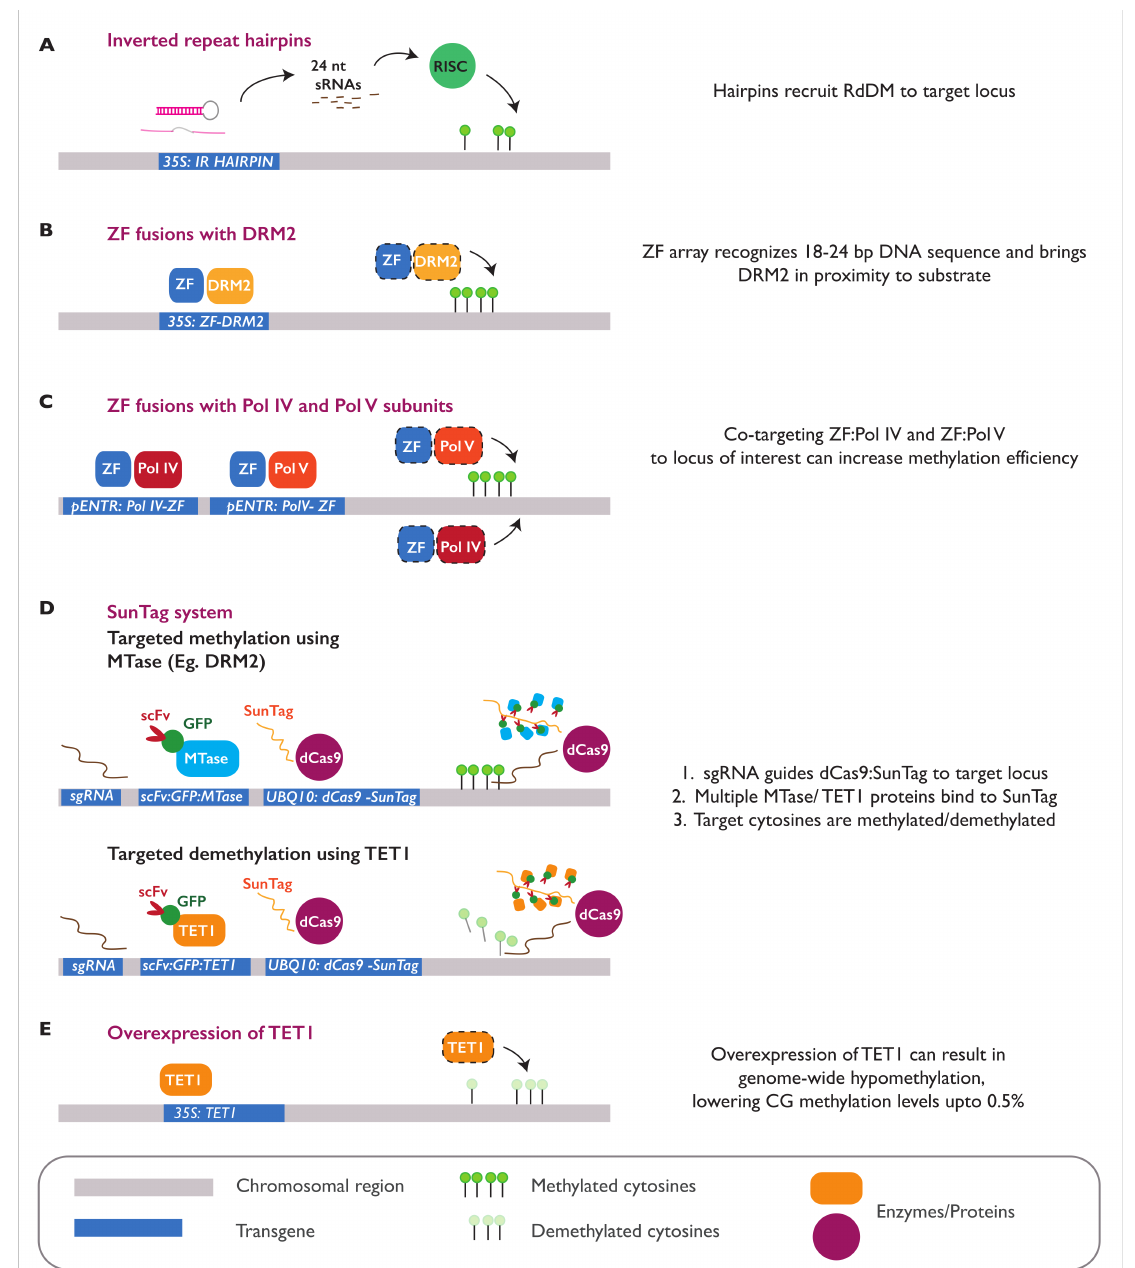
Figure 4. Different methods for targeted epigenetic engineering. DNA methylation can be introduced into specific regions in the genome using IR-hairpin constructs that can recruit a sRNA-induced silencing complex (RISC) into the target sequence ( A ), ZF constructs fused with methyltransferase genes such as DRM2 that can directly methylate cytosines at a target sequence through RdDM pathways ( B ), and ZF constructs fused with genes coding for Pol IV and Pol V subunits working in tandem to recruit RdDM machinery into the target sequence ( C ). Combining dCas9 with the SunTag system is another molecular engineering approach that allows the multimerization of multiple methyltransferases (“MTases”) (e.g., DRM2) or demethylases (e.g., TET1), which can selectively methylate or demethylate the target sequence, respectively ( D ). The SunTag system comprises two modules—the first being dCas9 and an epitope tail and the second being a single chain antibody (scFv) fused to GFP and the MTase of interest. The removal of genome-wide DNA methylation can also be catalyzed by overexpression of the TET1 gene ( E